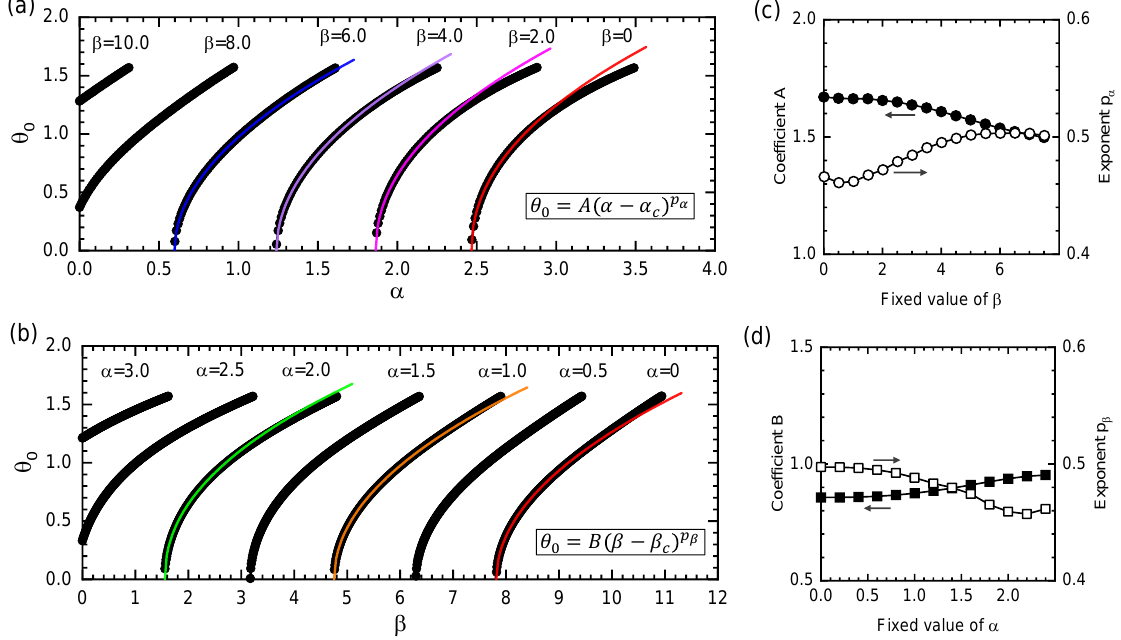
Figure 4. ( a , b ) Power-law dependences of θ 0 on α and β . The fitting curves for data points in the 0 < θ 0 < 1.0 range are also shown. ( c , d ) Optimal values of coefficients A and B , and those of exponents p α and p β